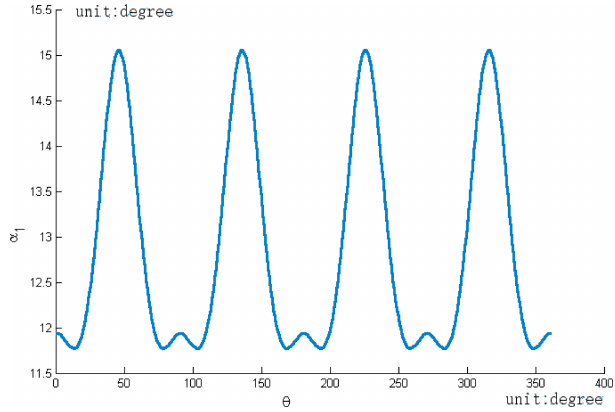
Figure 5. The relationship between the rotation angle α 1 and the perigon.